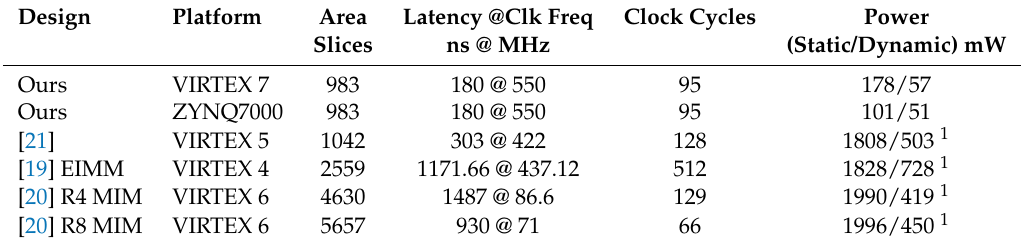
Table 1. Comparing our Radix-8 256-bit interleaved modular multiplication design performance with other works.